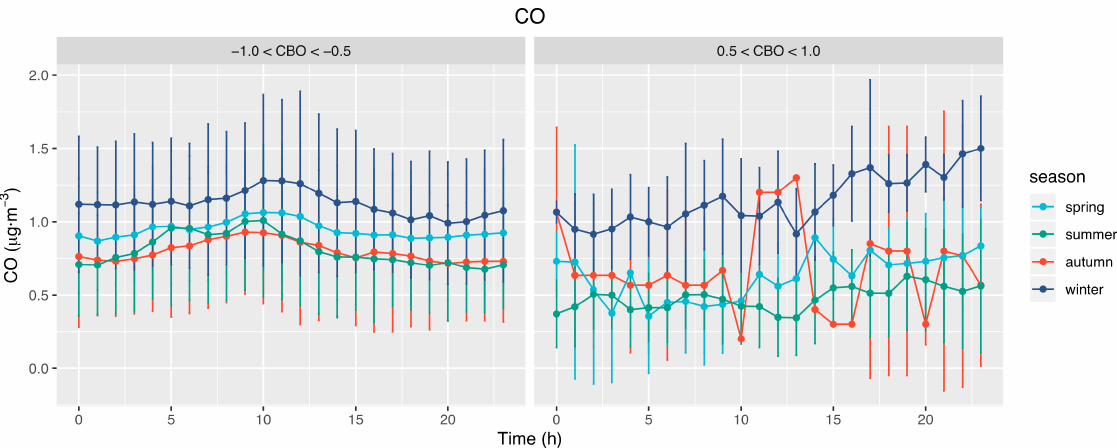
Figure 11. Diurnal variations of CO in two situations: ( left ): − 1.0 < CBO < − 0.5 and ( right ): 0.5 < CBO <